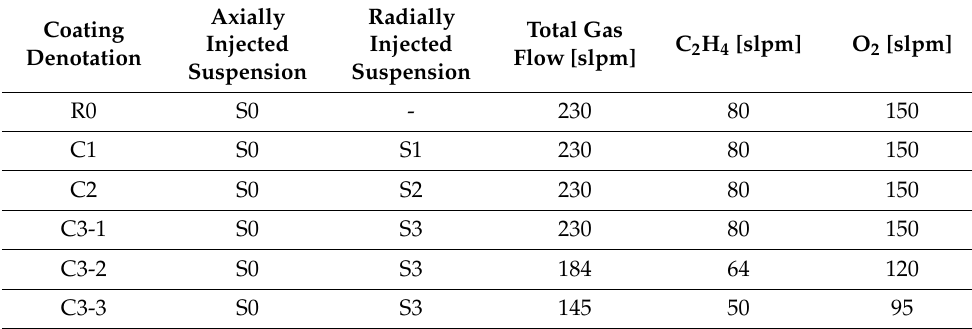
Table 2. Overview of the coating